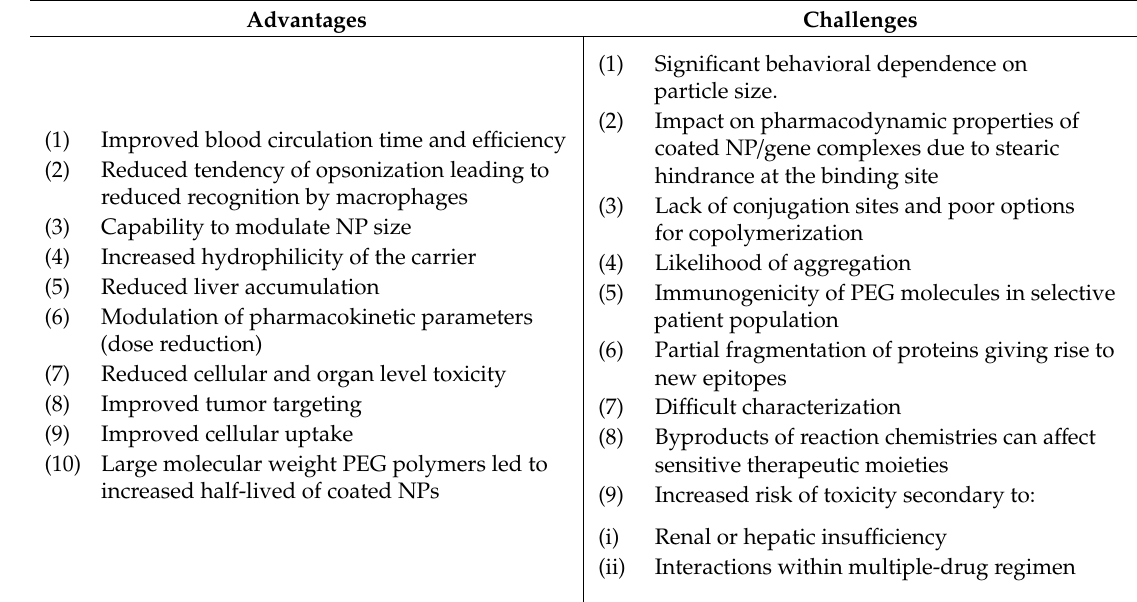
Table 3. Advantages and challenges for PEGylation of